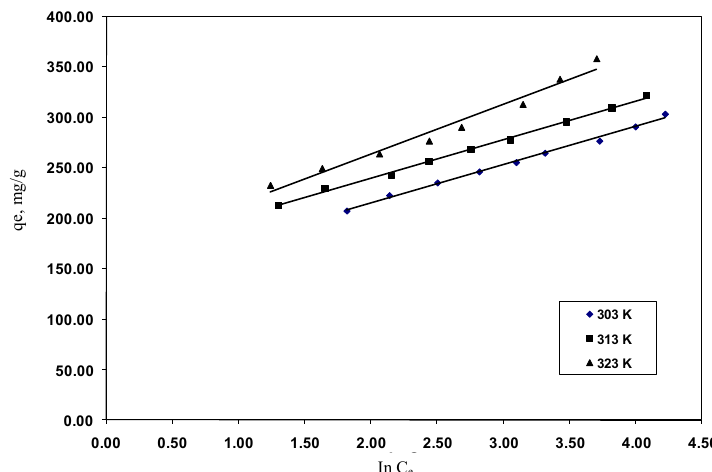
Figure 13. .Tempkin isotherm for the adsorption AG25 on to ACC at various Temperatures. Table 3 . Results of various isotherm plots for the adsorption of AG 25 on to ACC. Temperature,